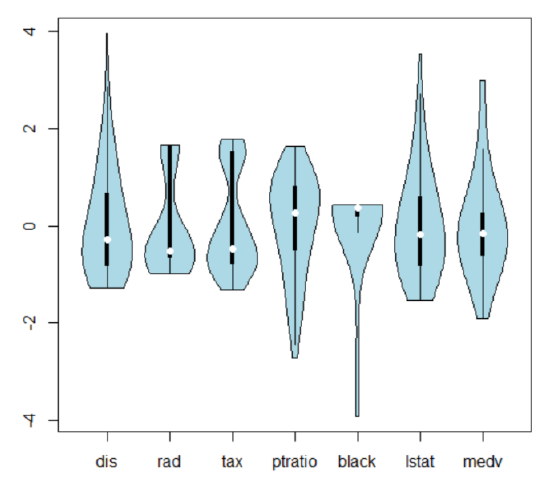
Figure 1. Violin diagram of the first seven variables.